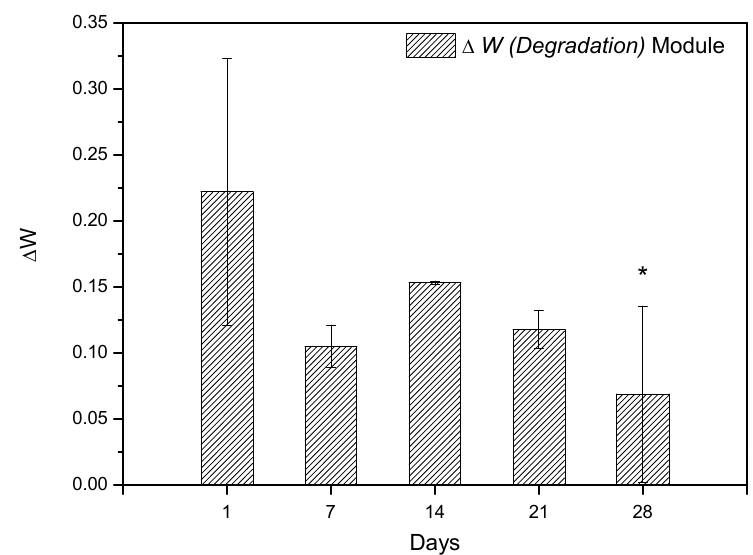
Figure 13. Weight variation of S HG scaffold during periods of 1, 7, 14, 21, and 28 days. The differences between the groups were analyzed by analysis of variance (ANOVA), followed by the Tukey test, comparing the groups with the value of 1 day, * represents statistically difference with 1 day.